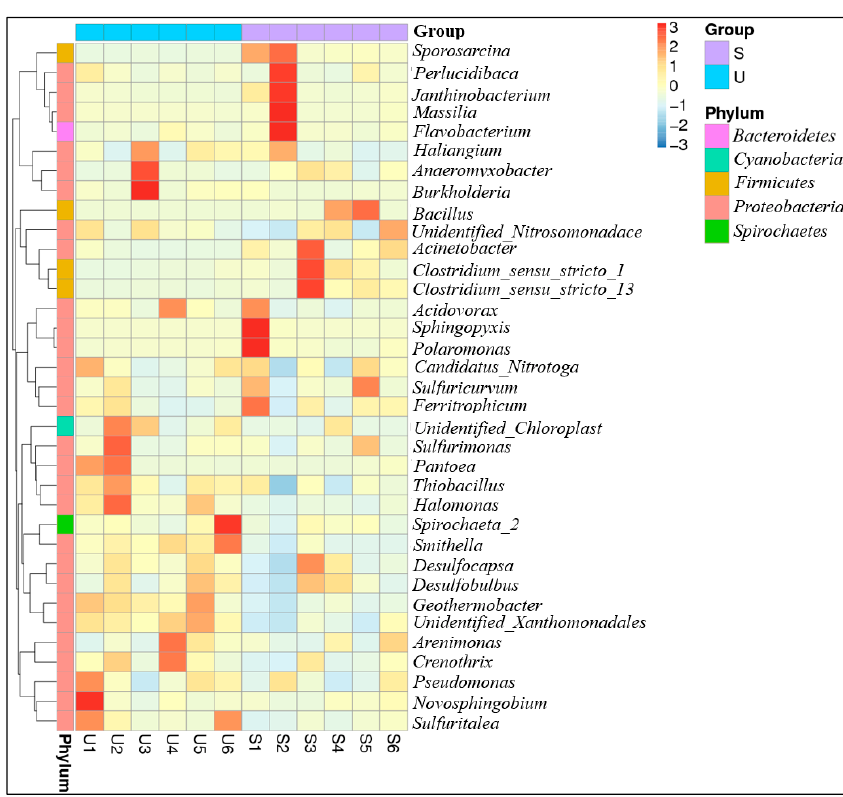
Figure 3. Heat map of top abundant genus level in each sample. The color intensity in each cell indicates the transformed relative abundance [log 2 (x + 0.01)] of a family in a sample, referring to color key at the right top of the figure. The families in blue or red showed lower or higher relative abundances among samples.